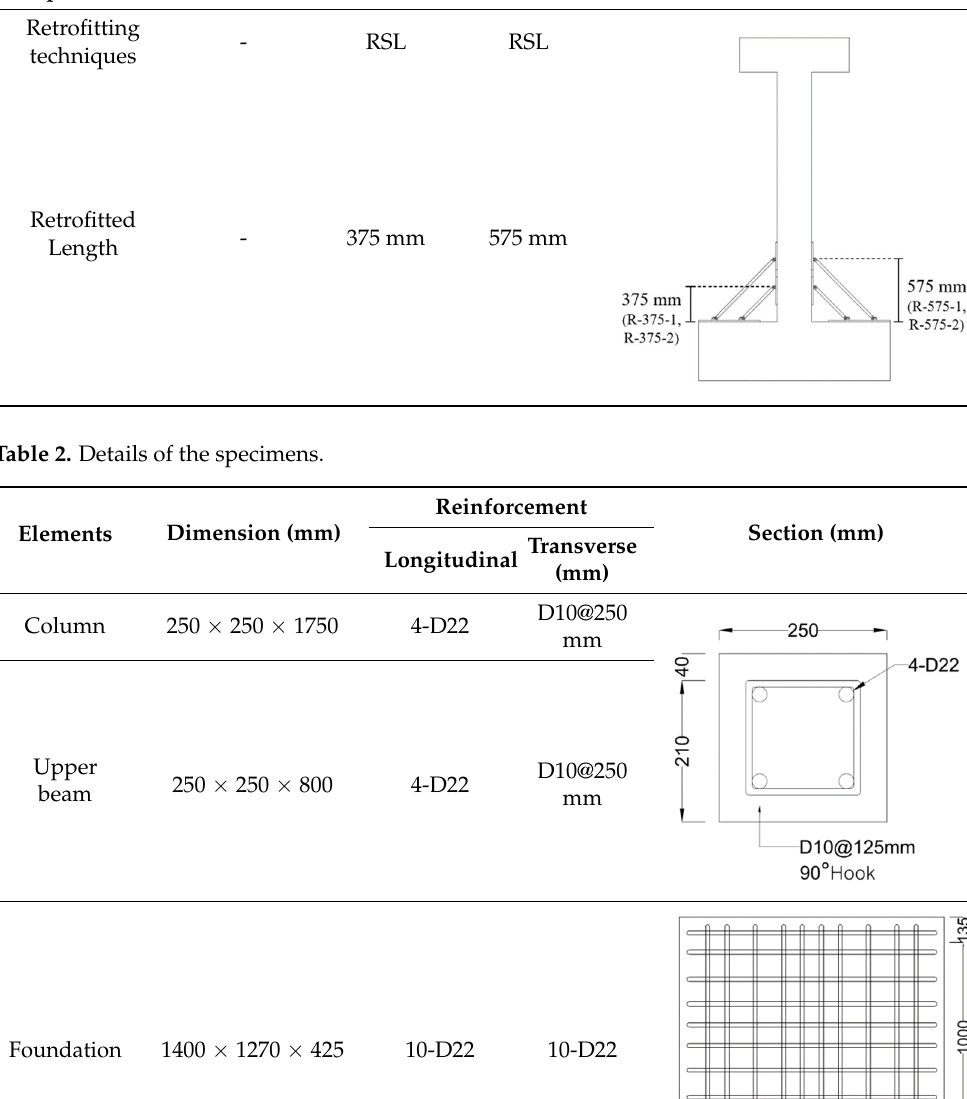
Table 1. Types and variables of the specimens.